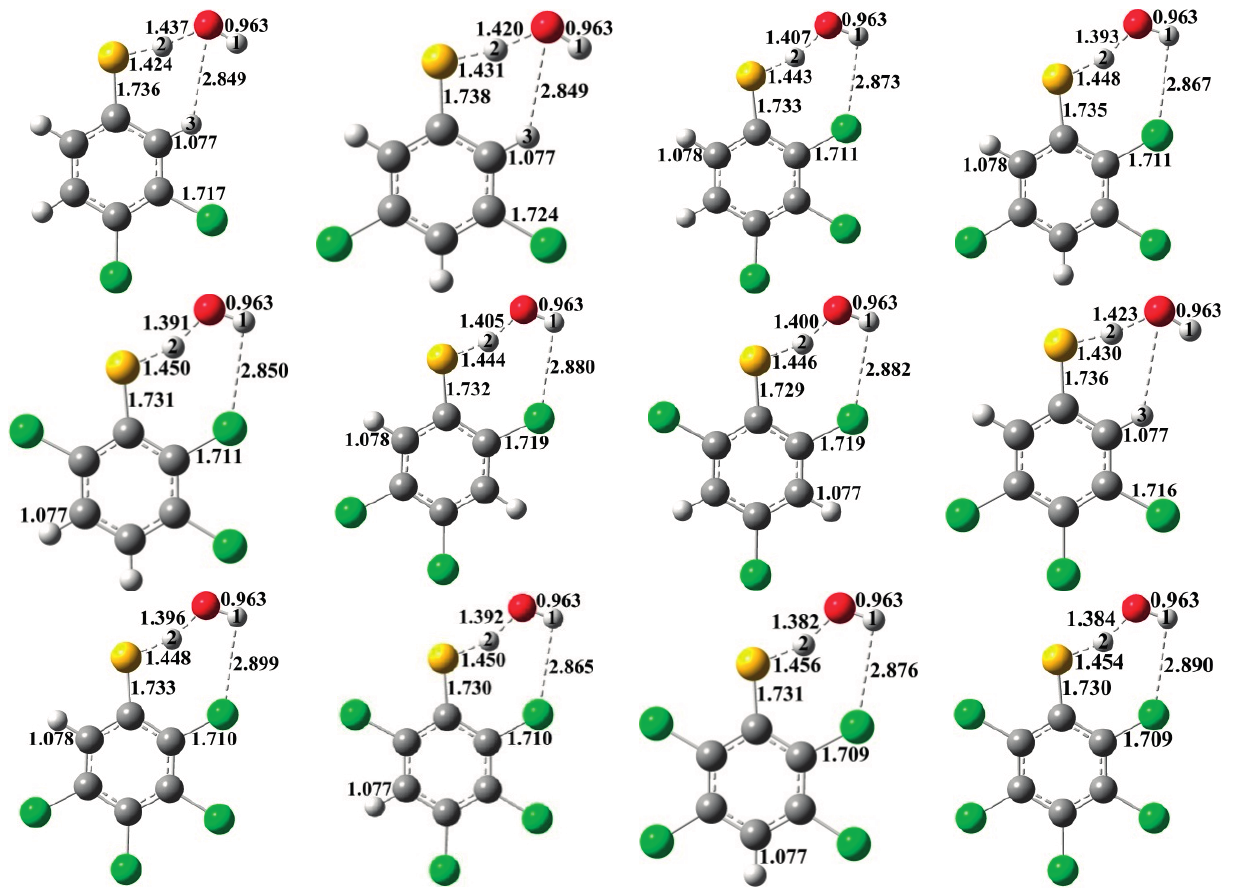
Figure 4. MPWB1K/6-31+G(d,p) optimized geometries for the transition states of the thiophenoxyl-hydrogen abstraction from CTPs by OH. Distances are in angstroms. Gray sphere, C; White sphere, H; Yellow sphere, S; Red sphere, O; Green sphere, Cl. (For interpretation of the references to color in this figure legend, the reader is referred to the web version of this article.) .